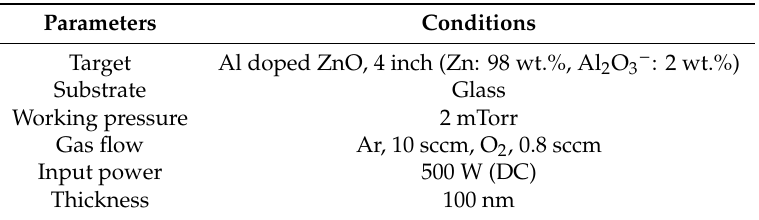
Table 1. Sputtering conditions.